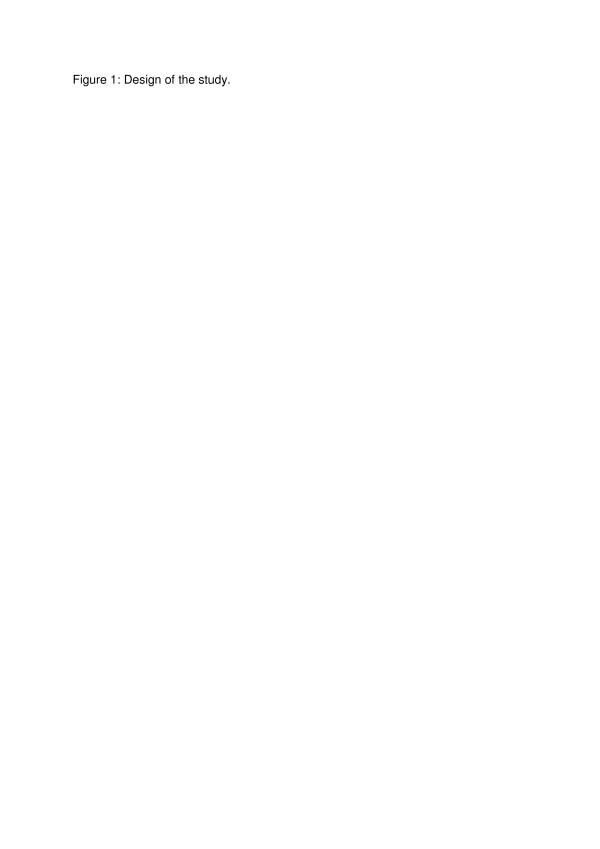
Design of the study.